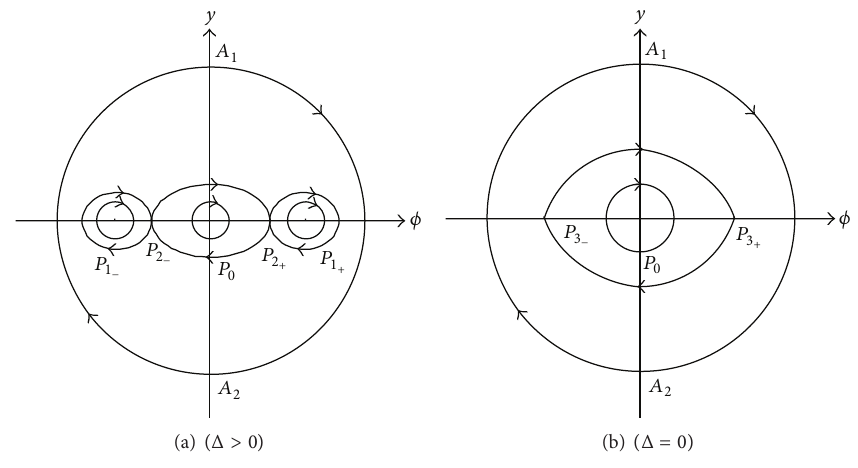
Figure 12: ( 𝛽 > 0 , 𝑎 < 0 , 𝑏 > 0 , 𝑐 < 0 ).